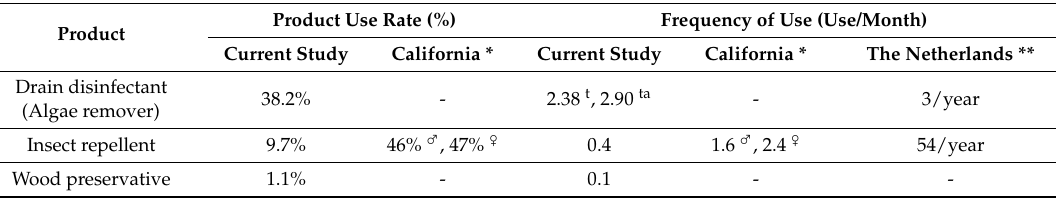
Table 5. Summary of the reported product use and frequency of